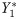
Global variability has large impact on mutual information.a) Initial distribution of Y1* before any input is given, reflecting cell-cell variability in initial conditions. In this case, the protein synthesis parameter is stochastic, reflecting a globally varying source of noise. S1 denotes the mean of the distribution, while S2 and S3 denote cells that are one standard deviation away from the mean. b) Time-dependent mutual information computed for heterogeneous initial conditions (the whole distribution in panel a, black), or homogeneous initial conditions (S1: red, S2: blue, and S3: green) c) Time-dependent dose-response relationships between y
2 and input at t = 750 minutes for a population starting from homogeneous initial conditions corresponding to S
1, S
2, and S
3. d) Time-dependent dose-response relationship between y
2 and input for heterogeneous initial conditions corresponding to full distribution in panel a. Calculations for panels a-d correspond to a slowly fluctuating global variable with γ
g = 3 × 10−8. e) Mutual information for different timescales of the fluctuations in the global variable.